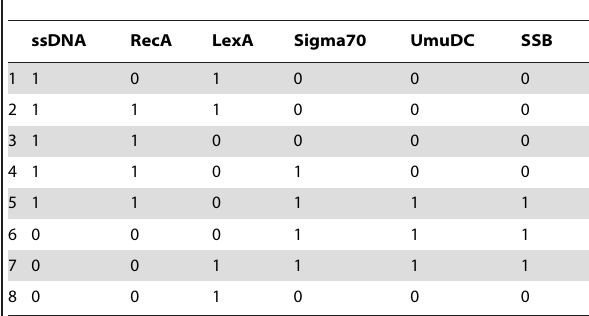
Table 3. The biological pathway of E.coli SOS network.